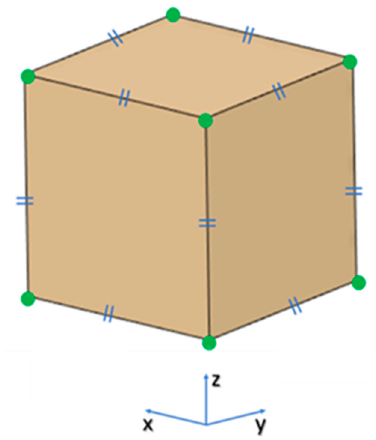
Figure 2. Projected view of a test object showing the landmark points: green points represent the landmark points for measurements and blue signs represent that the test object has equal dimensions (20 mm) in x-, y-, and z-axes.